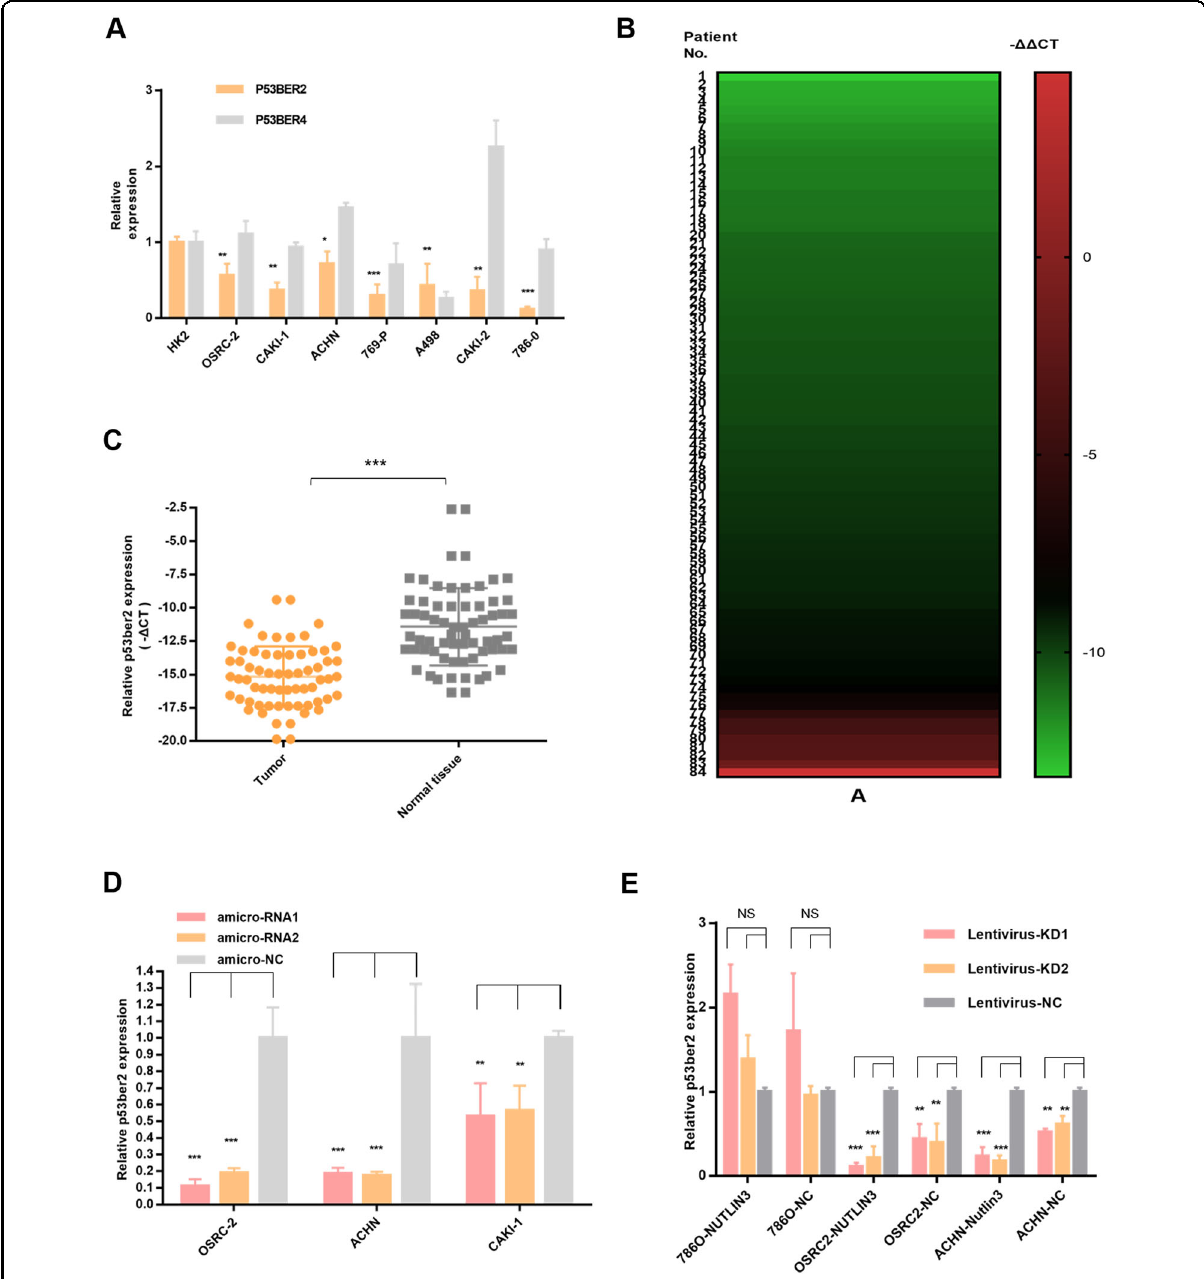
Fig. 1 Clinical information and p53-related eRNAs expression level in all the RCC tumor samples and cell lines. A P53-related eRNAs expression level in RCC cell lines. B The heatmap about the expression level of p53BER2 in 84 RCC tumor samples. C The expression of p53BER2 in RCC tumor samples and normal tissues. D The relative p53BER2 expression level in different RCC cell lines after transfecting amicroRNA. E The relative p53BER2 expression level in different RCC cell lines after infecting lentivirus. Results are shown as mean ± SD. *** P < 0.001 compared with control. ** P < 0.01 compared with control. * P < 0.05 compared with control. NS not signi fi